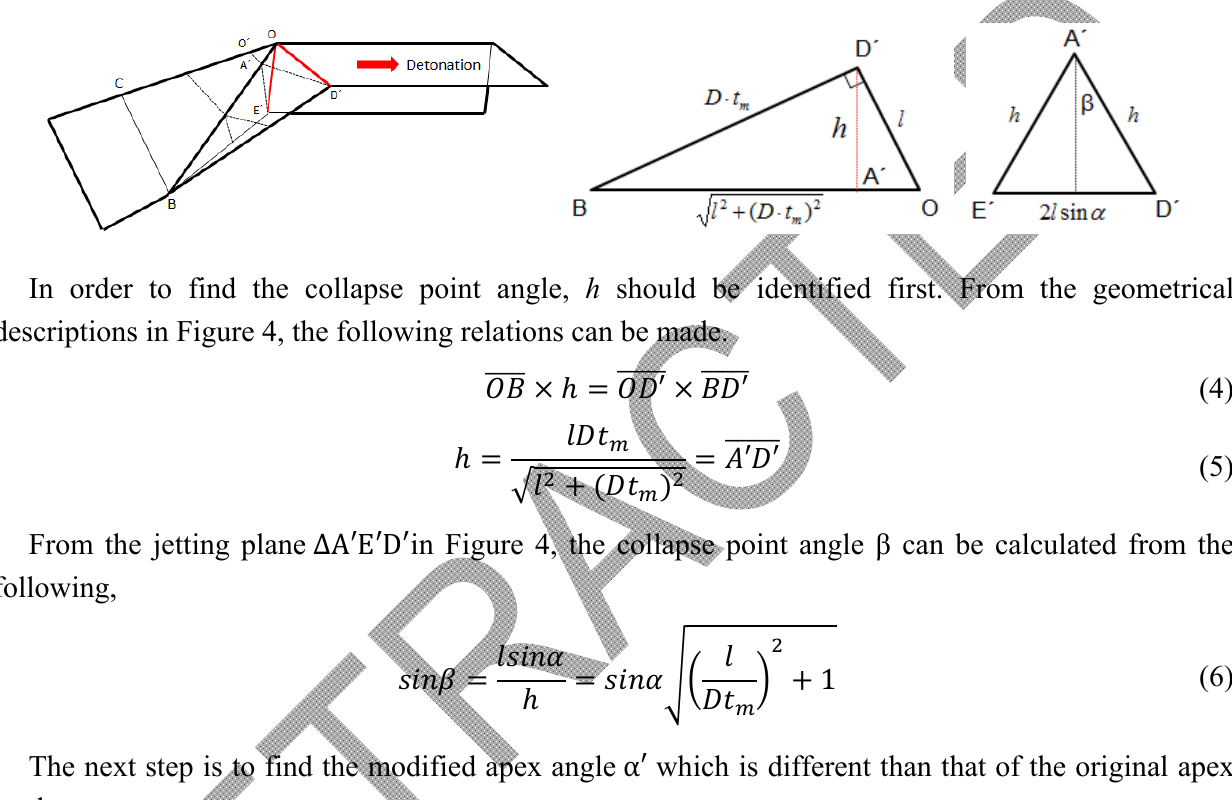
Figure 4. Jetting plane and liner.